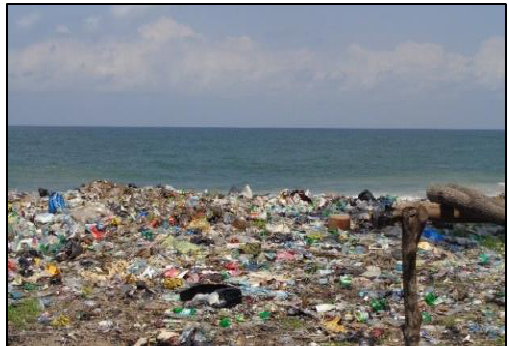
Figure 5. Flooded road due to lack of drainage